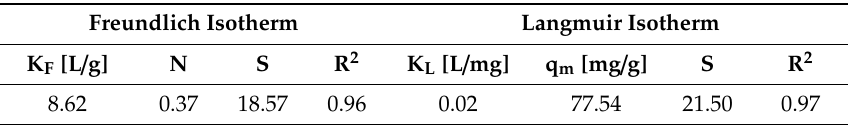
Table 3. Parameters of Freundlich and Langmuir approximation mathematical models of adsorption isotherms to the experimental